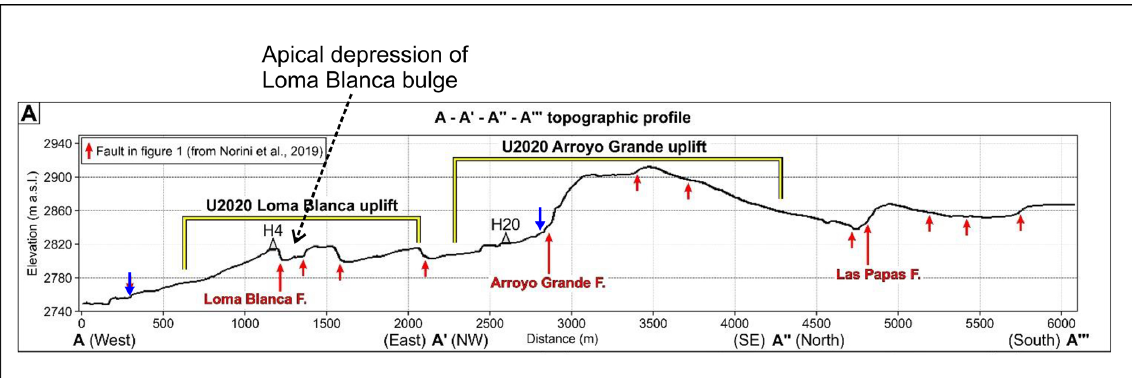
Figure 2. Trace of the A–A (cid:48) –A (cid:48)(cid:48) –A (cid:48)(cid:48)(cid:48) topographic profile of Norini and Groppelli (2020) showing the apical depression of the Loma Blanca bulge and reverse faults (blue arrows) at the base of the Arroyo Grande and Loma Blanca bulges identified by Norini et al. (2019). Modified from Fig. 4a of Norini and Groppelli